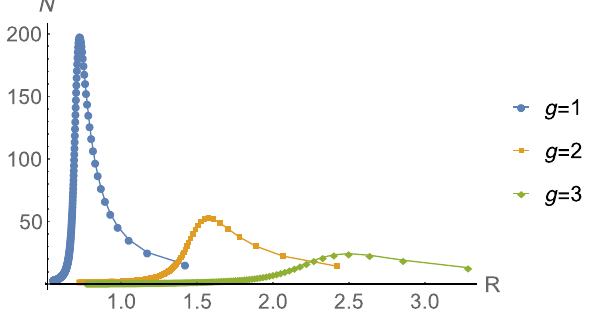
FIG. 8. The trade-off between clock accuracy N and resolution R for clockworks of various coupling constants g , where ½ g (cid:2) ¼ E and R is increased by decreasing d . Here, we consider only cases of M → ∞ and c ¼ 25 s − 1 . Increasing g shifts the peak toward the right, i.e., to higher resolutions, while decreasing the maximum